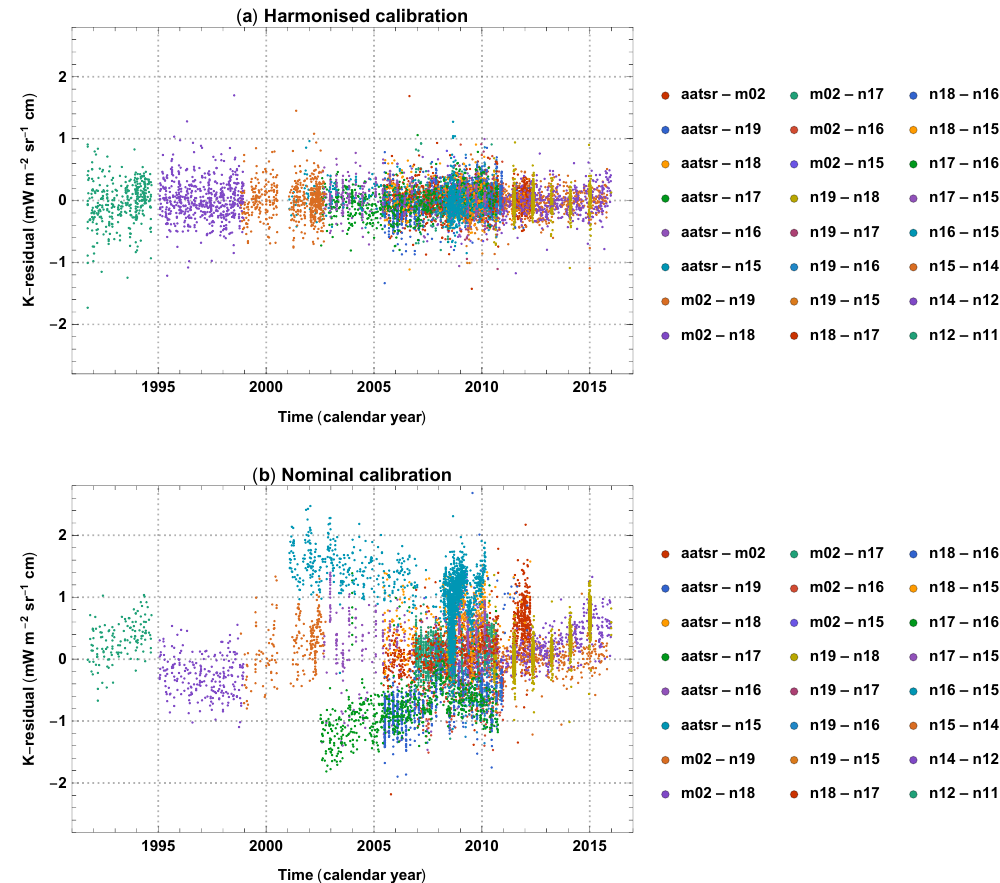
Figure 7. Random sample of 10,000 matchups from all sensor pairs. ( a ) top panel: K -residuals calculated from the harmonised calibration; ( b ) bottom panel: the same samples, but calculated from the nominal AVHRR